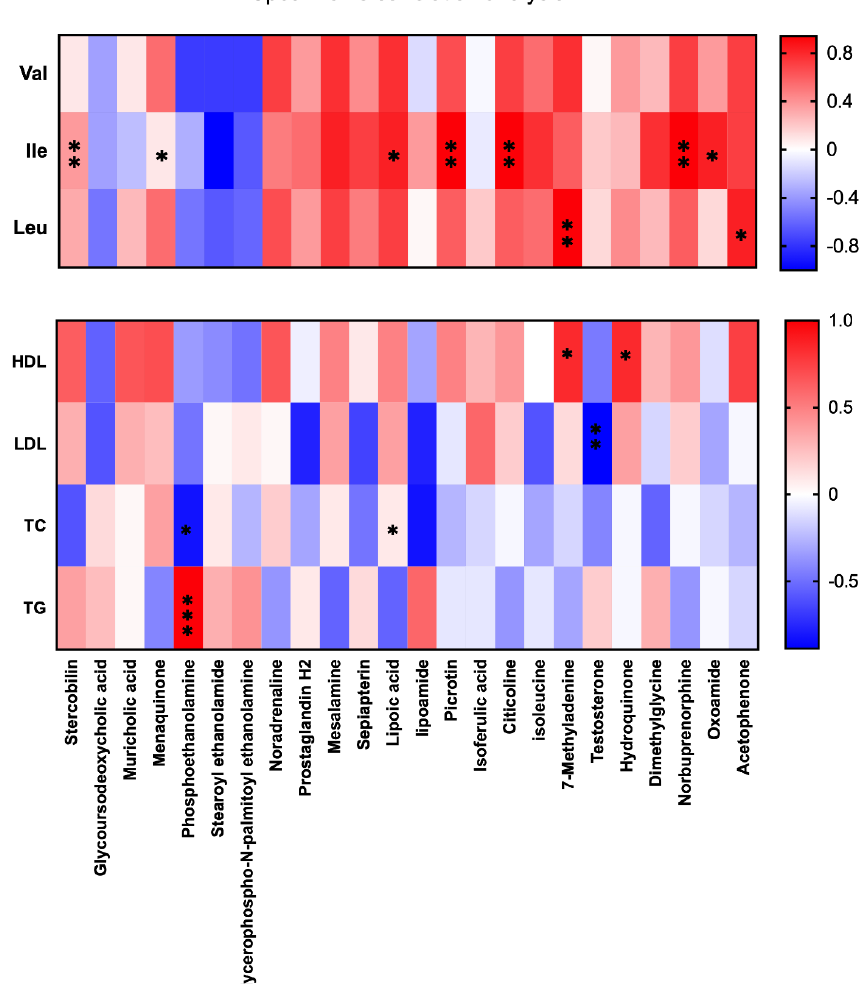
Figure 6. Correlation analysis of metabolic phenotype among serum BCAA concentration and serum lipid biomarkers. Spearman’s correlation analysis was conducted, and the correlation coefficient was used for the heat map: * p < 0.05; ** p < 0.01; *** p < 0.001. Each dietary group comprised n = 6 mice.